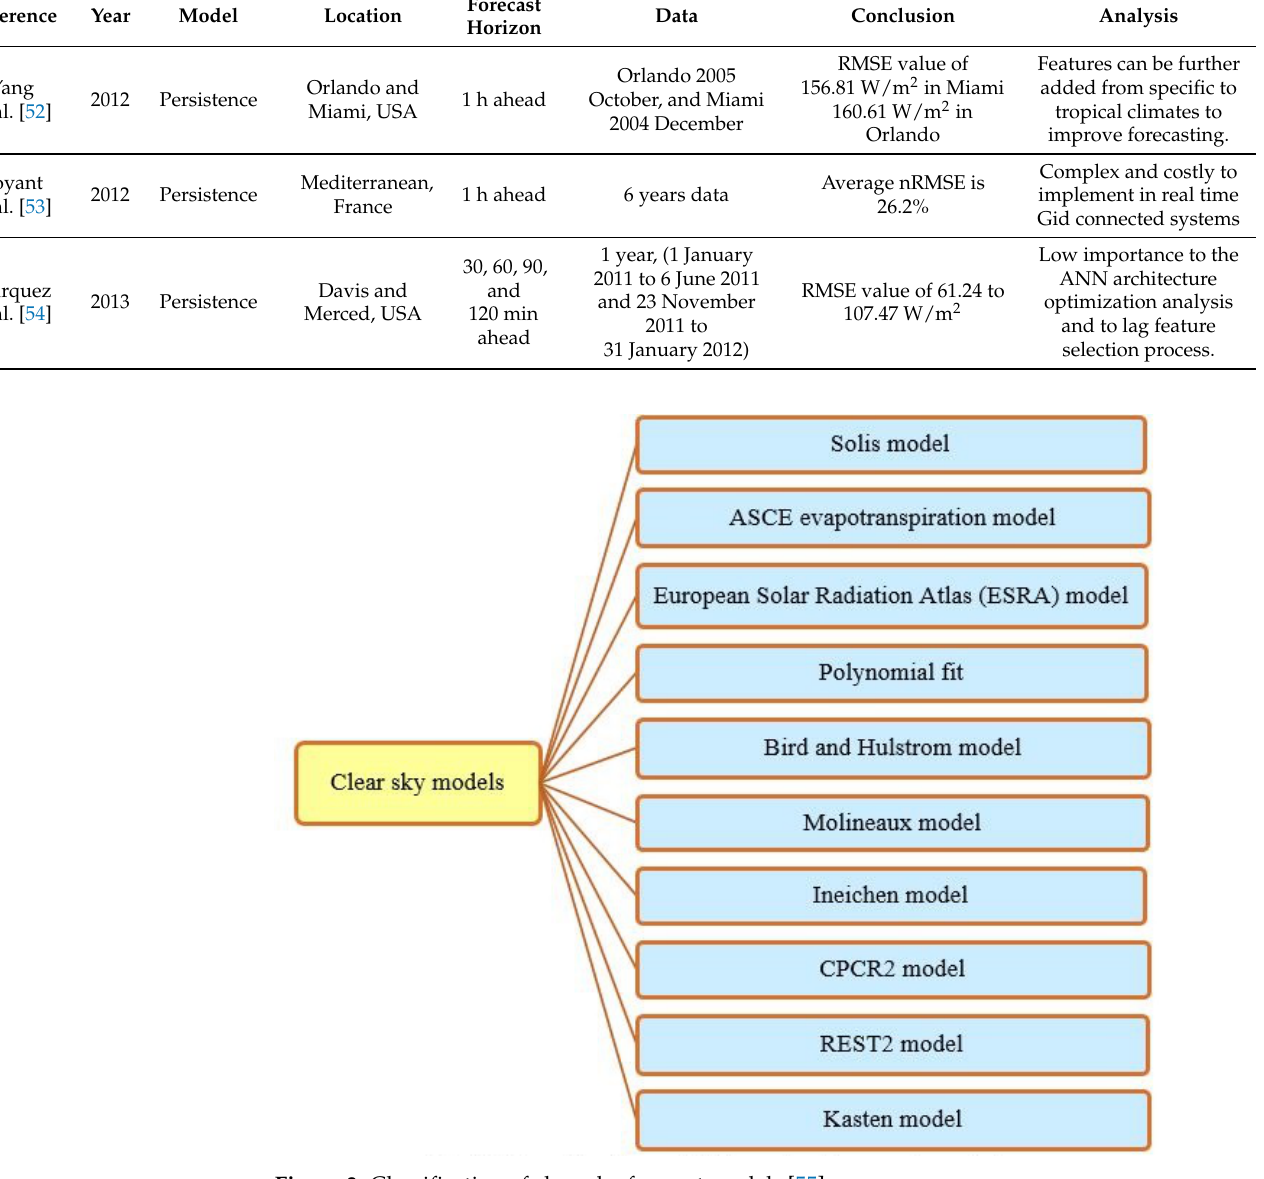
Figure 3. Classification of clear sky forecast models